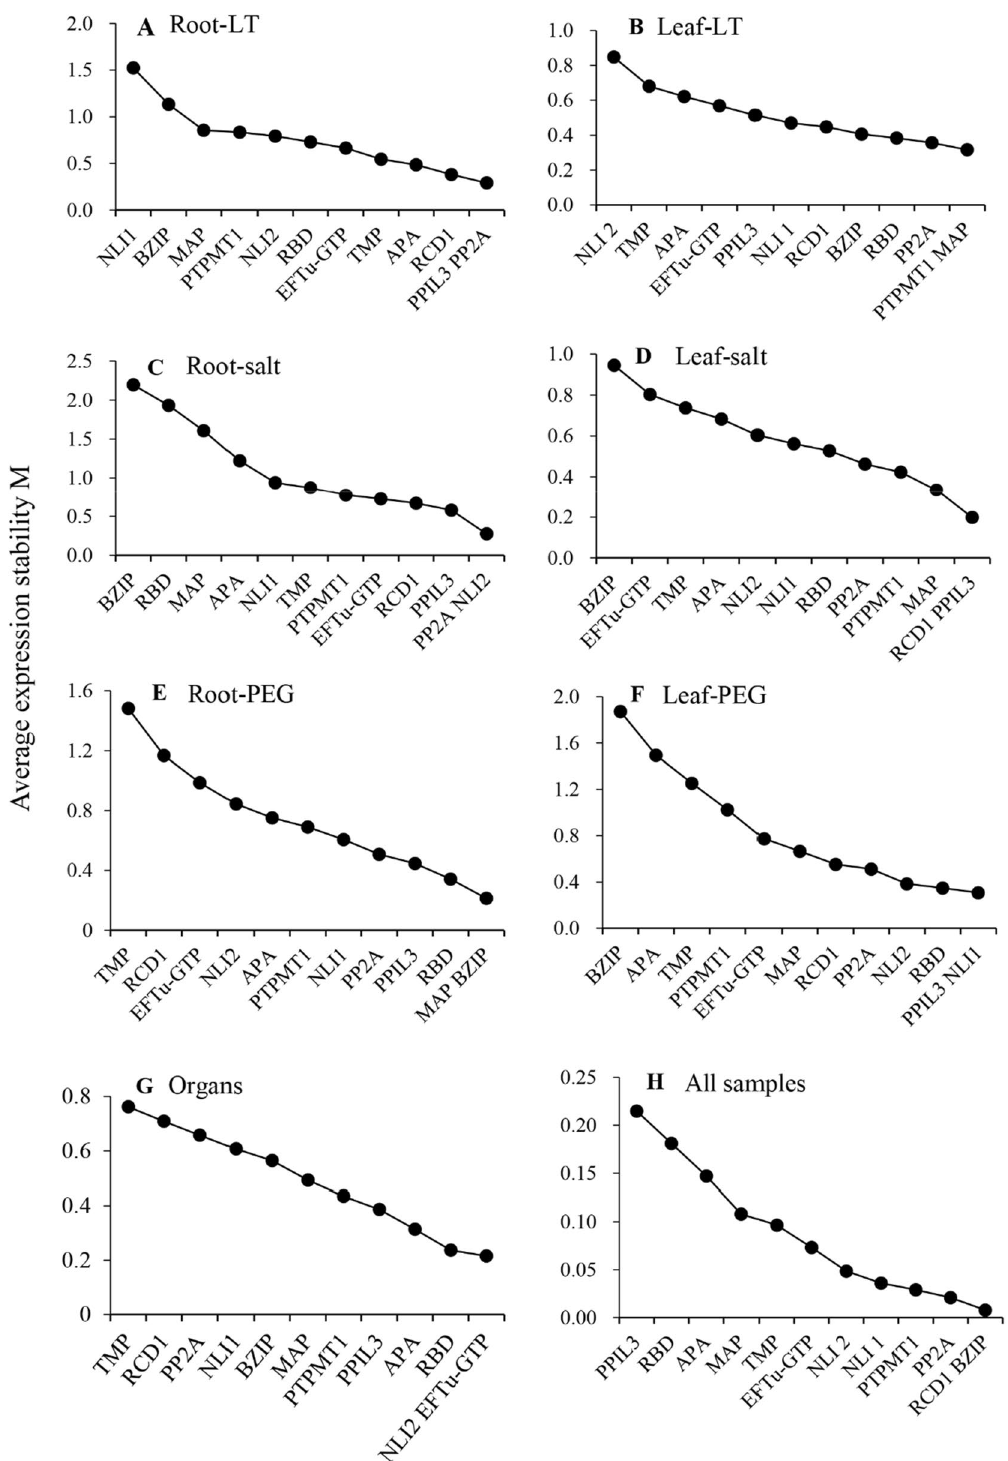
Figure 3. Average M values of the 12 candidate reference genes according to geNorm. The expression stability was evaluated in samples from organs, in all samples, and in the roots and leaves of Caucasian clover subjected to low-temperature, salt and 10% PEG treatments. The least stable reference genes, which have relatively high M values, are shown on the left, and the most stable reference genes, which have relatively low M values, are shown on the